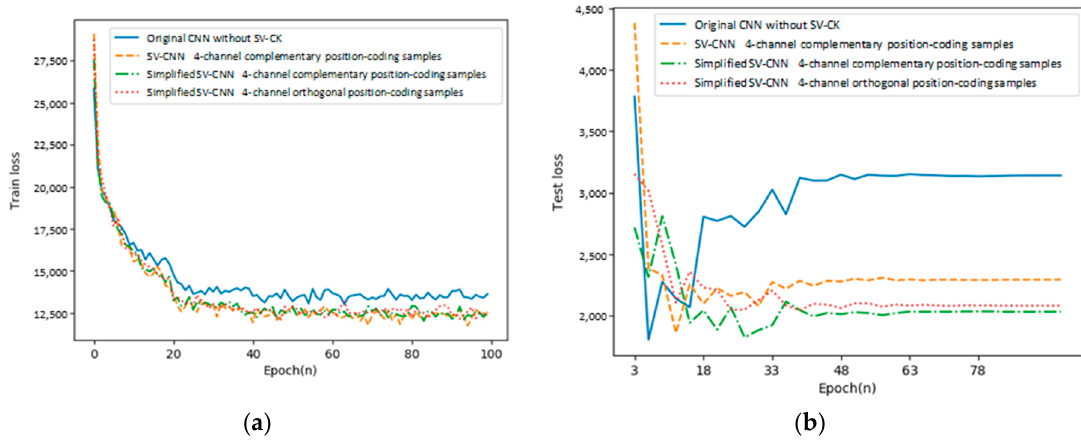
Figure 12. Training loss and testing loss of the CNN, the SV-CNN, and the simplified SV-CNNs; ( a ) training loss; ( b ) testing loss.